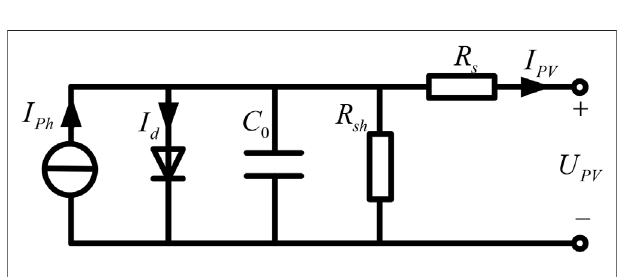
FIGURE 2 | Equivalent circuit of the photovoltaic